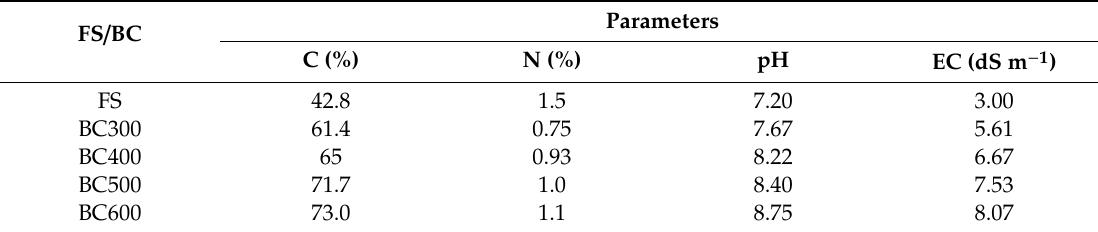
Table 1. Basic characteristics of date palm residue BC used in the current